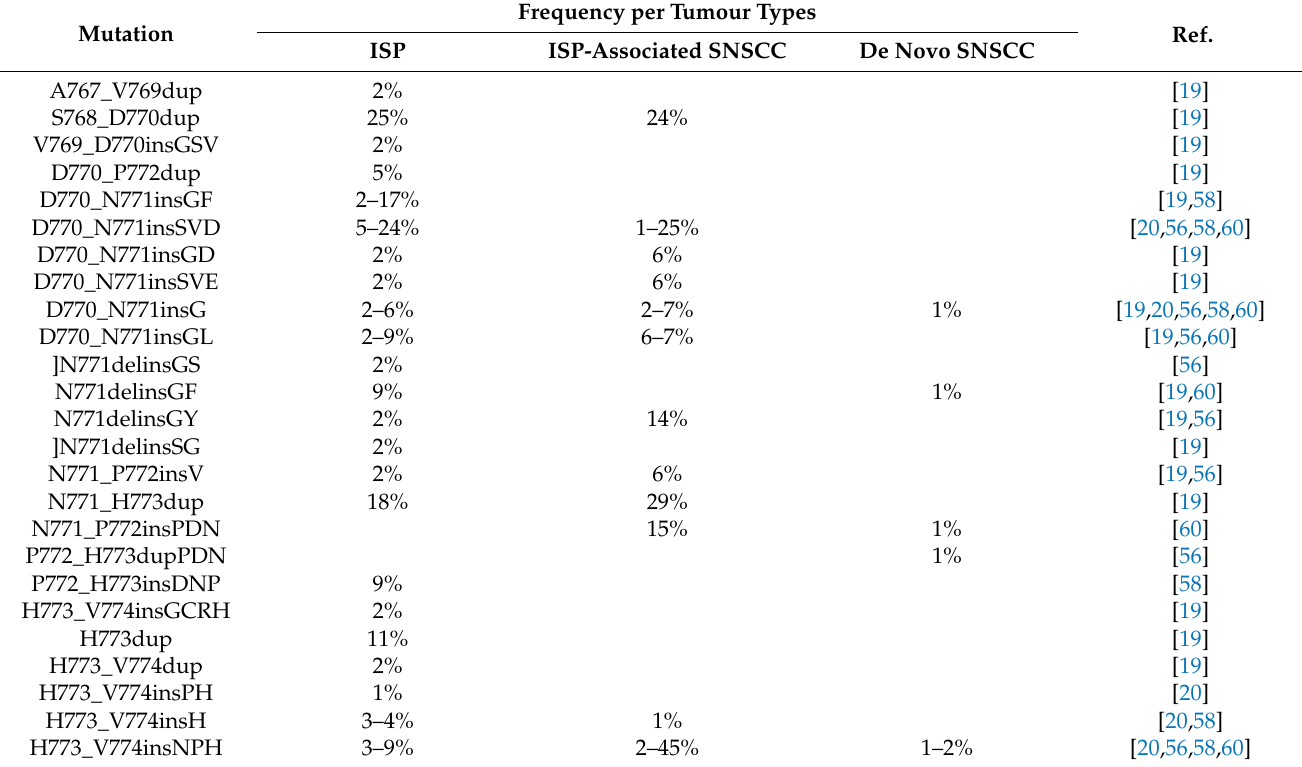
Table 1. Prevalence and distribution of EGFR exon 20 insertions in ISP, ISP-associated SNSCC and de novo